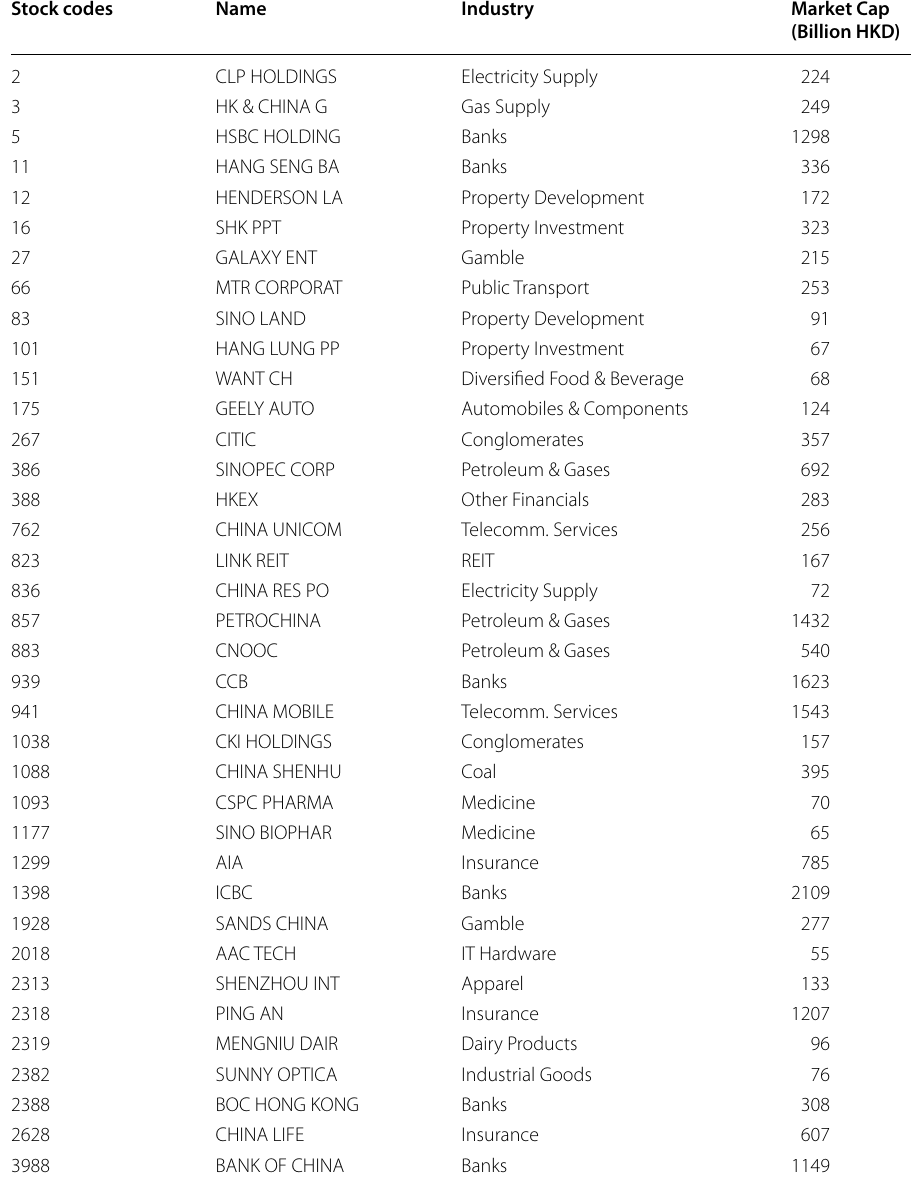
Table 1 List of Hong Kong stocks with market capitalization on December 31, 2018 Stock